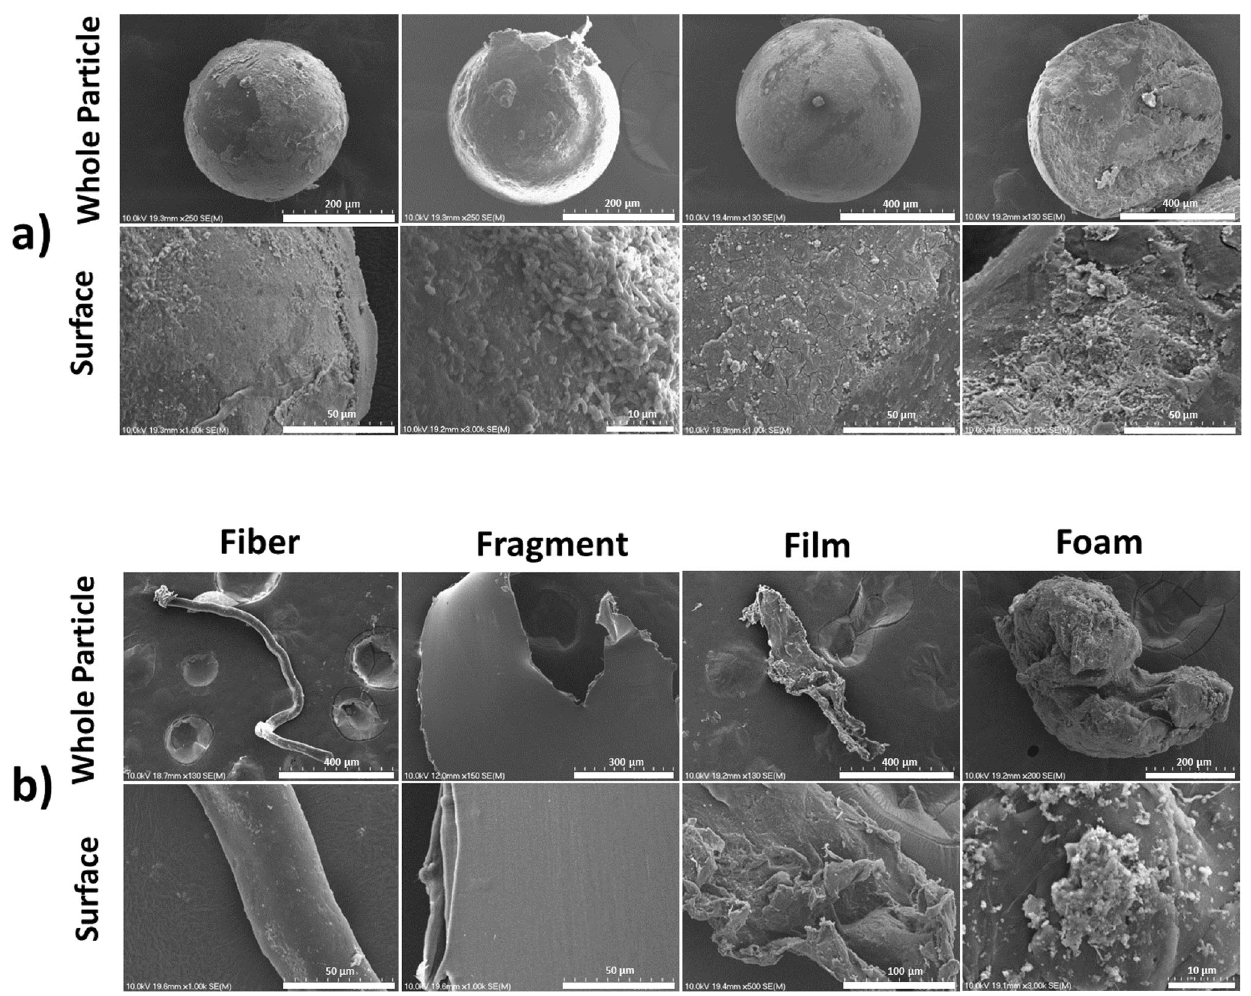
Fig. 4 SEM images of MPs with different shapes extracted from biosolids. Since the growth of bio fi lms on the bead surfaces was considerably higher than any other MP type, four different beads and their surfaces are individually magni fi ed in panel ( a ). Panel ( b ) shows fi ber, fragment, fi lm, and foam MP types and their